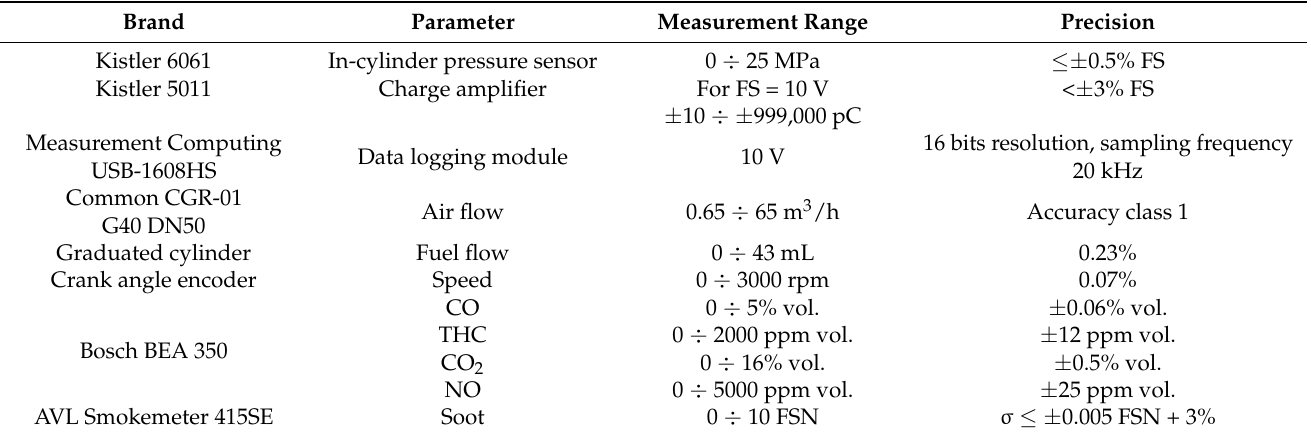
Table 1. Technical specifications of the test